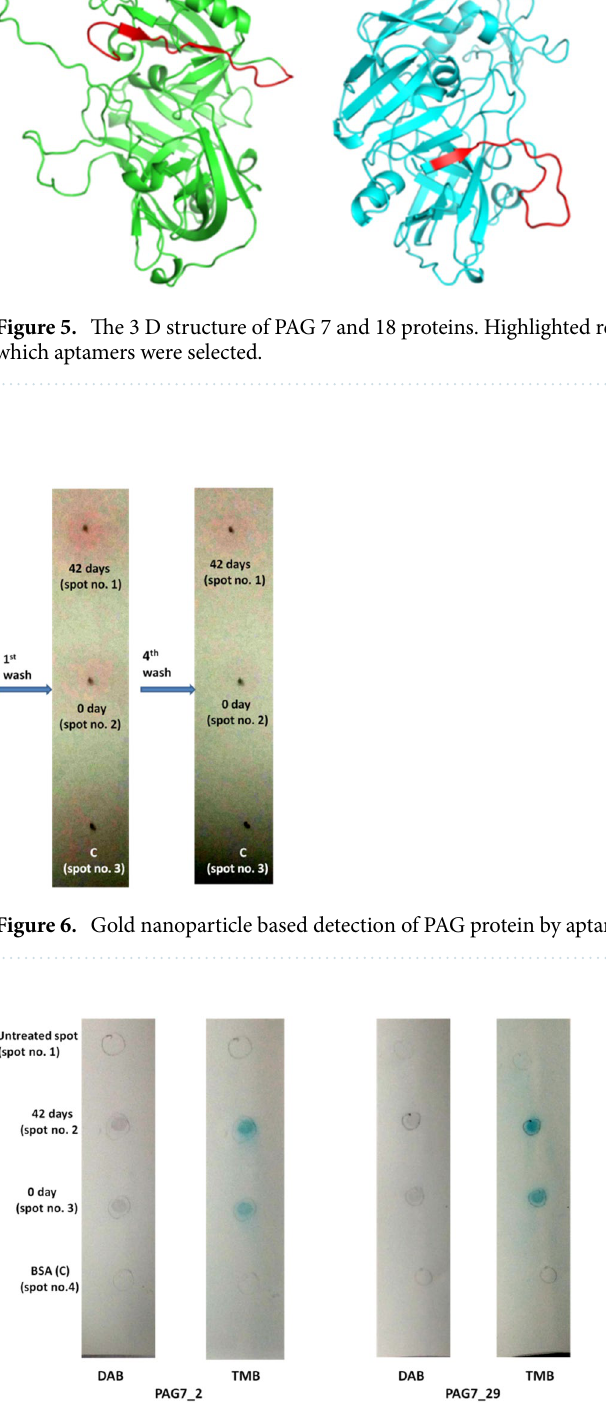
Figure 7. PAG7_2 and 29 interaction with PAG protein of pregnant sample of